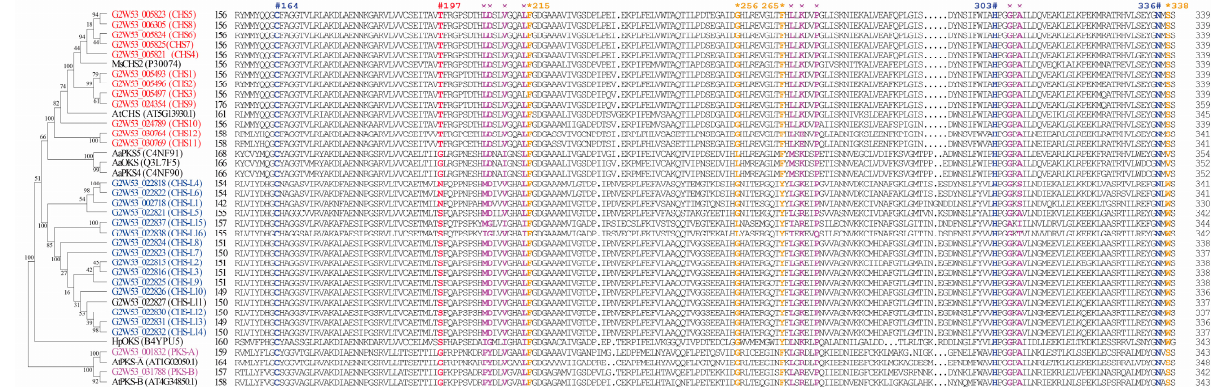
Figure 4. Comparison analysis of the deduced amino acid sequences of type III PKSs in Senna tora and other plant species. The first two letters of each gene indicate the abbreviated species name. Ms: Medicago sativa , At: Arabidopsis thaliana , Aa: Aloe arborescens , Hp: Hypericum perforatum . CHS: chalcone synthase, PKS: polyketide synthase, OKS: octaketide synthase, CHS-L: chalcone synthase-like. The catalytic triad (Cys164, His303 and Asn336) (in blue) and the critical active-site residue 197 (in red) are marked with #; the residues lining the active site (Phe215, Gly256, F265, and Ser338) (in yellow) are marked with * (numbering in M. sativa CHS), and the residues for the CoA binding (in purple) are marked with ×.